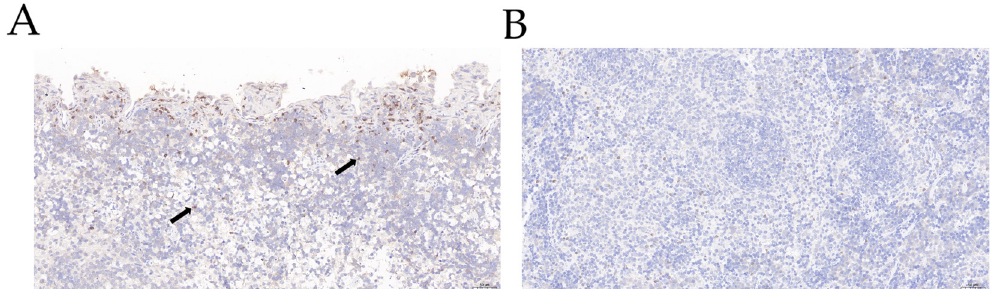
Figure 3. IL-10 immunodetection in challenge group ( A ) and control group ( B ). ( A ) IL-10 positive signal in mouse spleens from challenge group was increased significantly and was mostly expressed in the cytoplasm of macrophages (black arrow), 20× magnification. ( B ) No obvious aggregation of IL-10-positive cells group, 20× magnification. Table 2. Bacterial loads of mice spleens in challenge group.